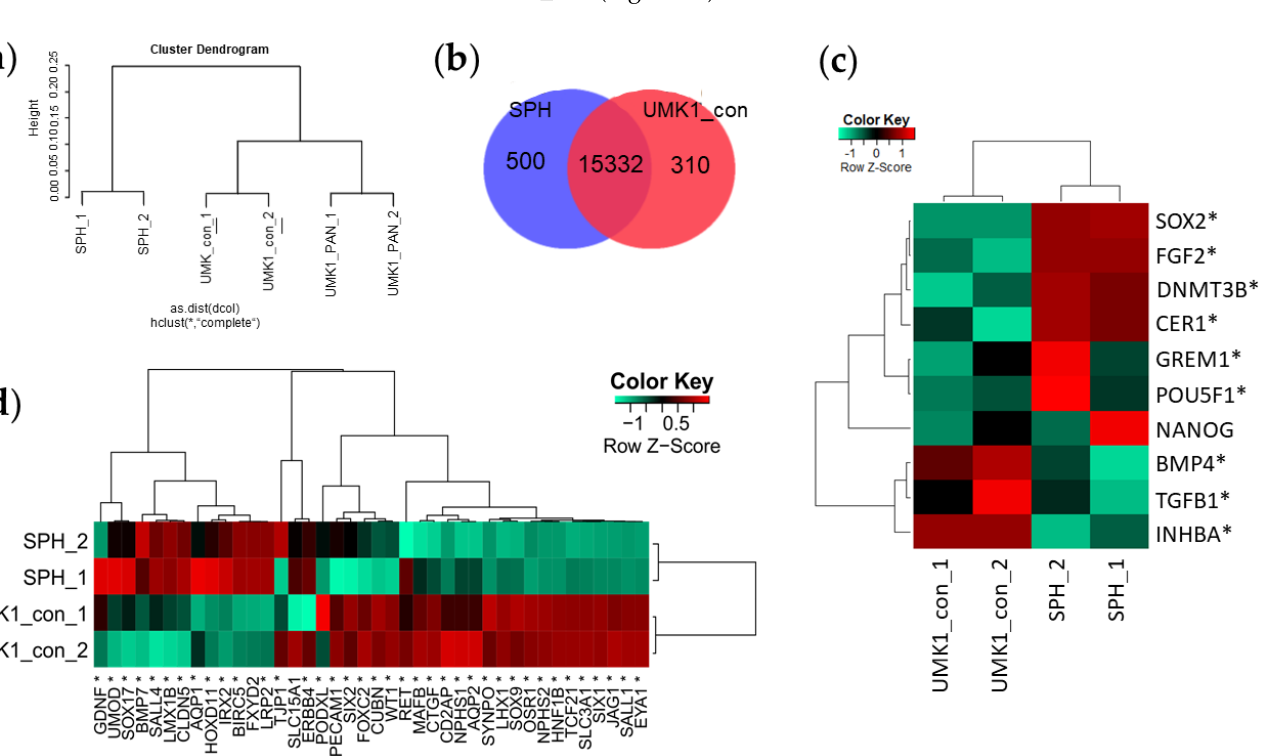
Figure 2. Comparative analysis of gene expression in iPSC spheroids and kidney organoids. ( a ) Similarities between spheroids and non-treated and PAN-treated organoids are shown in the cluster dendrogram. Control and PAN-treated UMK1 cluster together, and iPSC spheroids cluster separately. ( b ) The common gene-sets between spheroids and untreated kidney organoids consists of 15,332 genes. In total, 500 genes are exclusively expressed in spheroids and 310 genes in control organoids. ( c ) Expression of pluripotency-associated genes in UMK1_con and SPH depicted in a Pearson heatmap. ( d ) Expression of kidney-associated genes in UMK1_con and SPH depicted in a Pearson